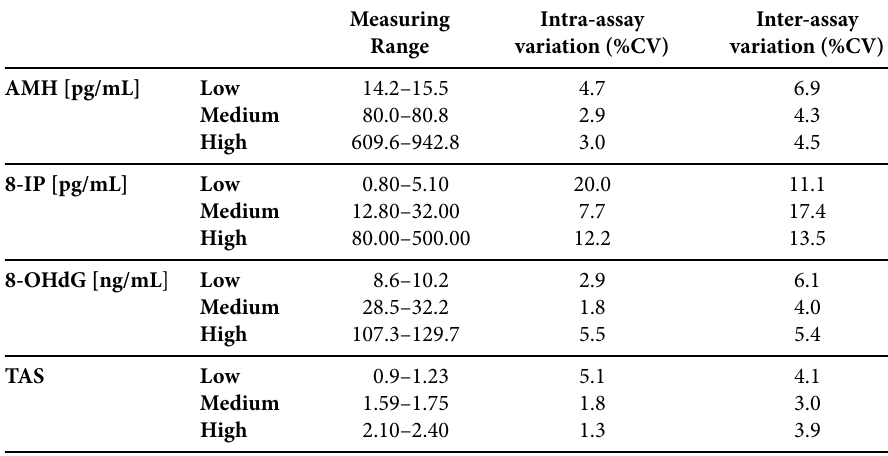
Table 2: Characteristic of the tests